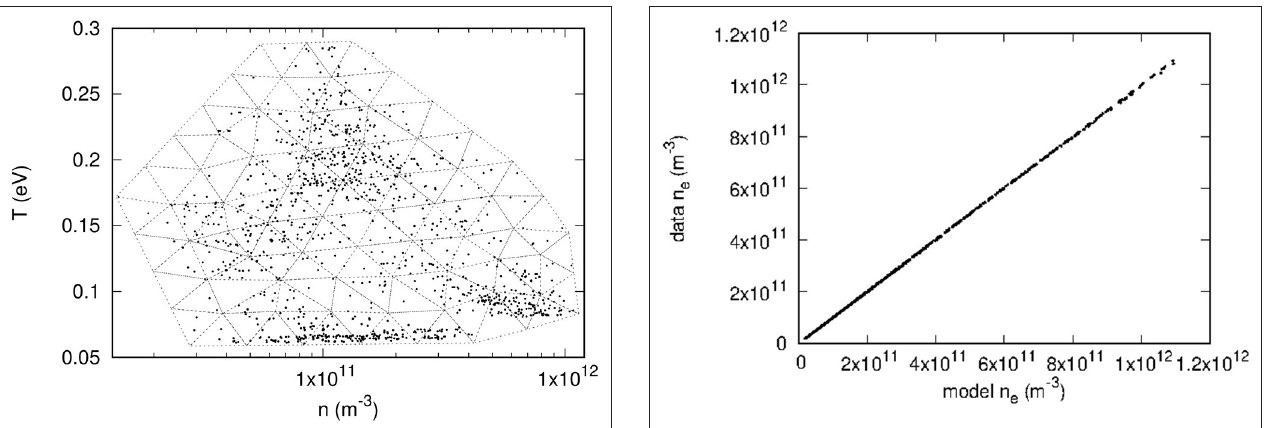
FIGURE 2 | Illustration of a 70 vertex triangular mesh used to find optimal T parameter space. pivot positions in n −